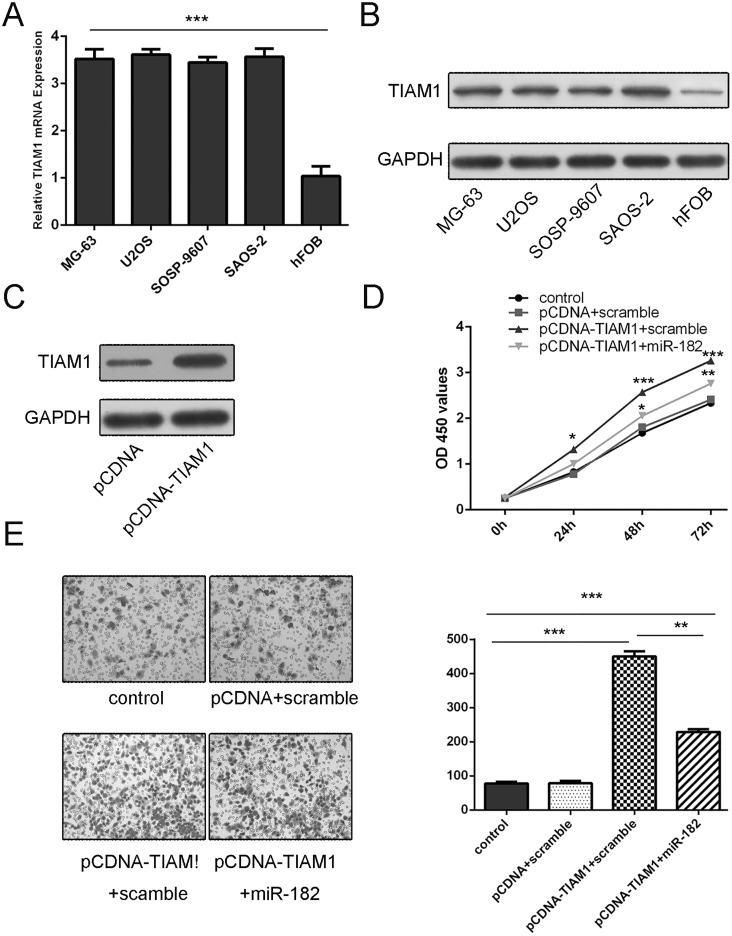
Restoration of miR-182 inhibits TIAM1-inducing osteosarcoma cell proliferation and invasion.(A) qRT-PCR analysis of TIAM1 expression in osteosarcoma cell lines (U2OS, MG-63, SOSP-9607, and SAOS-2) and human normal osteoblastic cell line (hFOB). The mRNA expression of TIAM1 was up-regulated in osteosarcoma cell lines. The expression of TIAM1 was normalized to GAPDH. (B) Western blot analysis of TIAM1 expression in osteosarcoma cell lines (U2OS, MG-63, SOSP-9607, and SAOS-2) and human normal osteoblastic cell line (hFOB). The protein expression of TIAM1 was up-regulated in osteosarcoma cell lines. GAPDH was also detected as a loading control. (C) The effects of pCDNA-TIAM1 on the expression of TIAM1 was detected by Western blotting. GAPDH was also detected as a loading control. (B) The cell growth in MG-63 co-transfected with either miR-182 mimic or scramble and 2.0 μg pCDNA-TIAM1 or pCDNA empty vector using CCK-8 proliferation assay. (C) The cell invasive in MG-63 co-transfected with either miR-182 mimic or scramble and 2.0 μg pCDNA-TIAM1 or pCDNA empty vector using invasion assay. *p<0.05, ** p<0.01, and ***p<0.001.